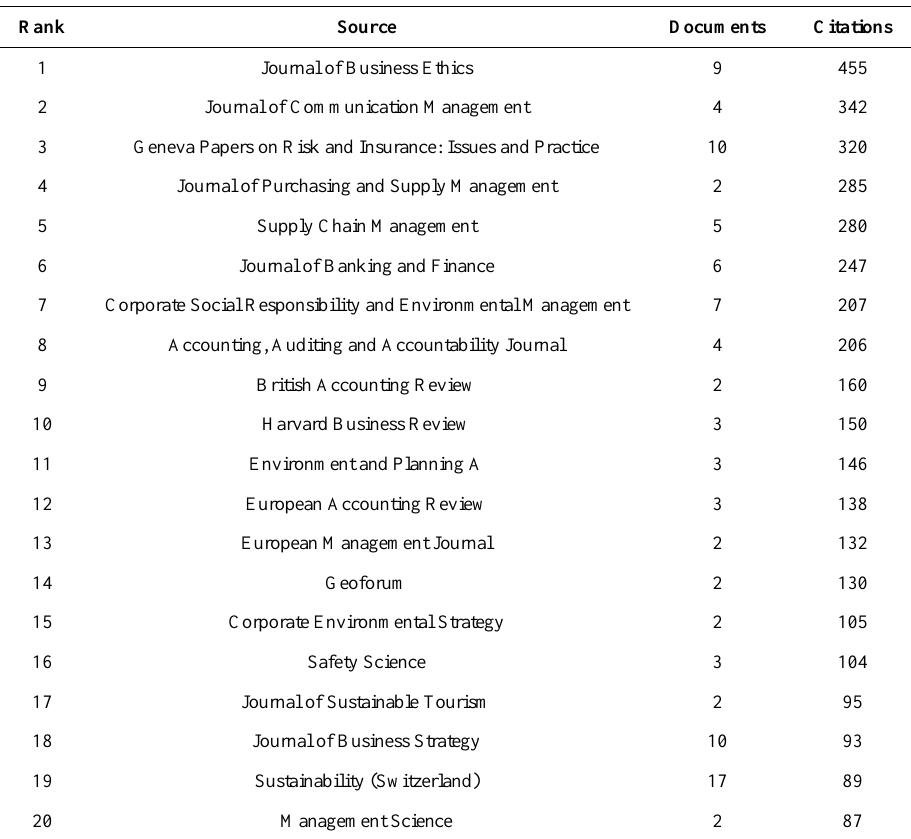
Table 2. Sources of published reputation risk